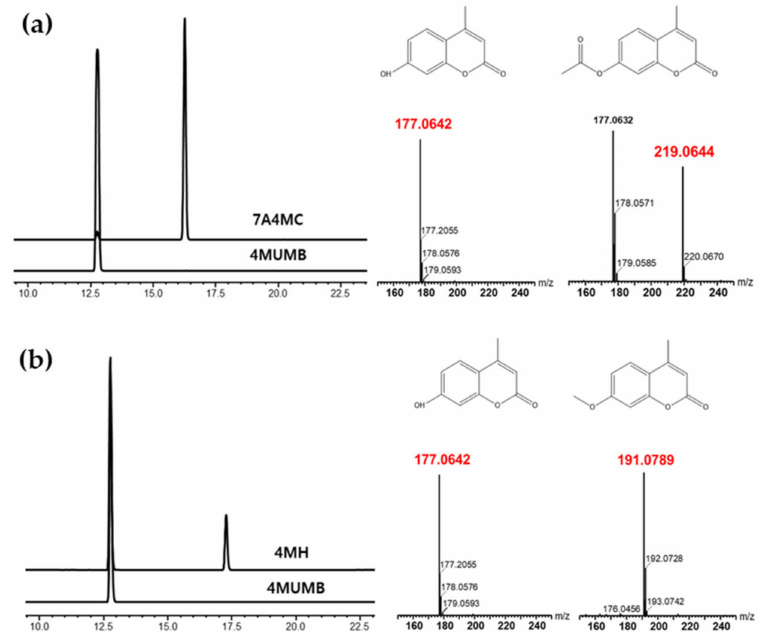
Figure 1. ( a ) High-pressure liquid chromatography (HPLC) analysis of 4-methylumbelliferone (4MUMB), 7-acetoxy-4-methylcoumarin (7A4MC), Structure and Mass analysis of 4MUMB and 7A4MC. ( b ) HPLC analysis of 4MUMB, 4-methylheriniarin (4MH), Structure and Mass analysis of